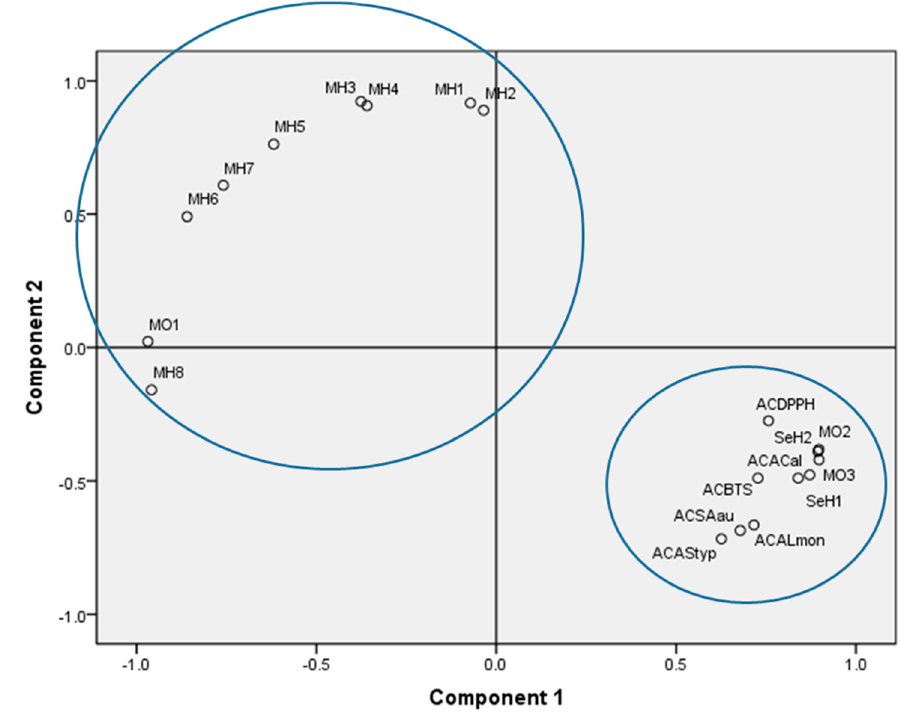
Figure 2. Diagram of the variables generated by the analysis of main components. ACDPPH means antioxidant activity by DPPH Methods, ACBTS means antioxidant activity by ABTS method, ACSAau means antimicrobial activity against Staphylococcus aureus , ACALmon means antimicrobial activity against Listeria monocytogenes , ACAStyp means antimicrobial activity against Salmonella typhi , ACAcal means antimicrobial activity against Candida albicans .